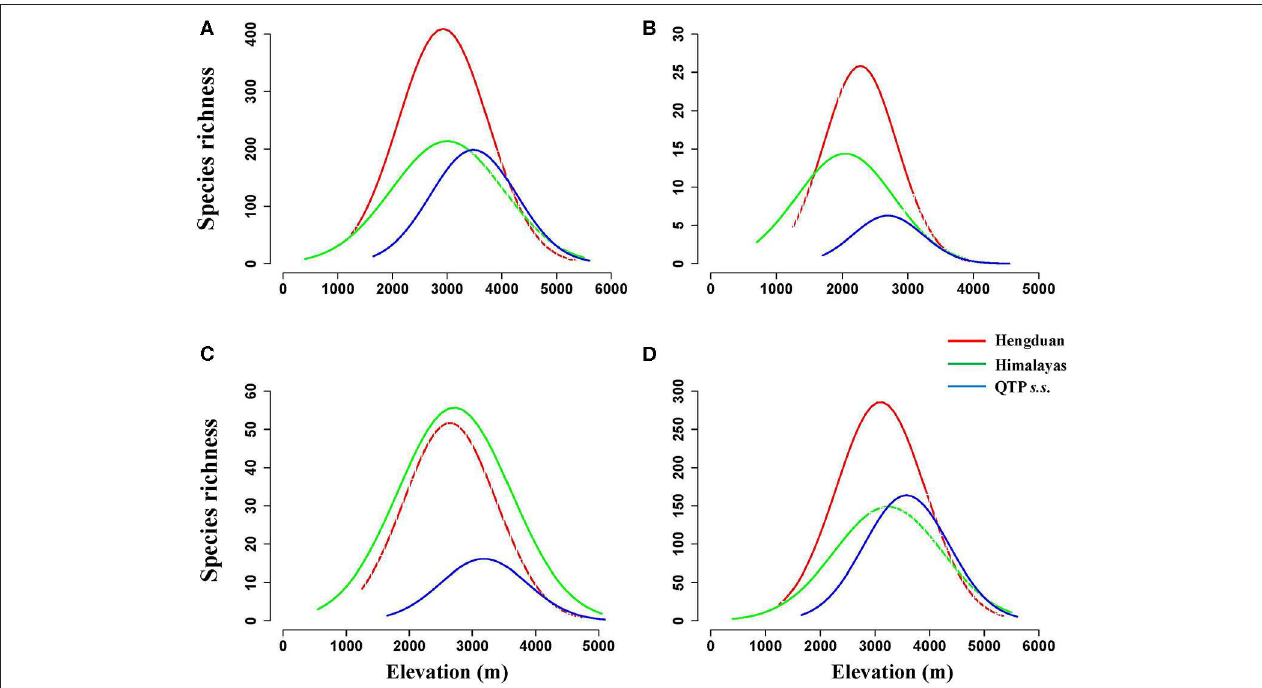
FIGURE 3 | Elevational patterns of species richness among the Hengduan Mountains, the Himalayas, and the Qinghai-Tibet Plateau s.s. for different life-forms taxa. (A) all species. (B) tree species. (C) shrub species. (D) herbaceous